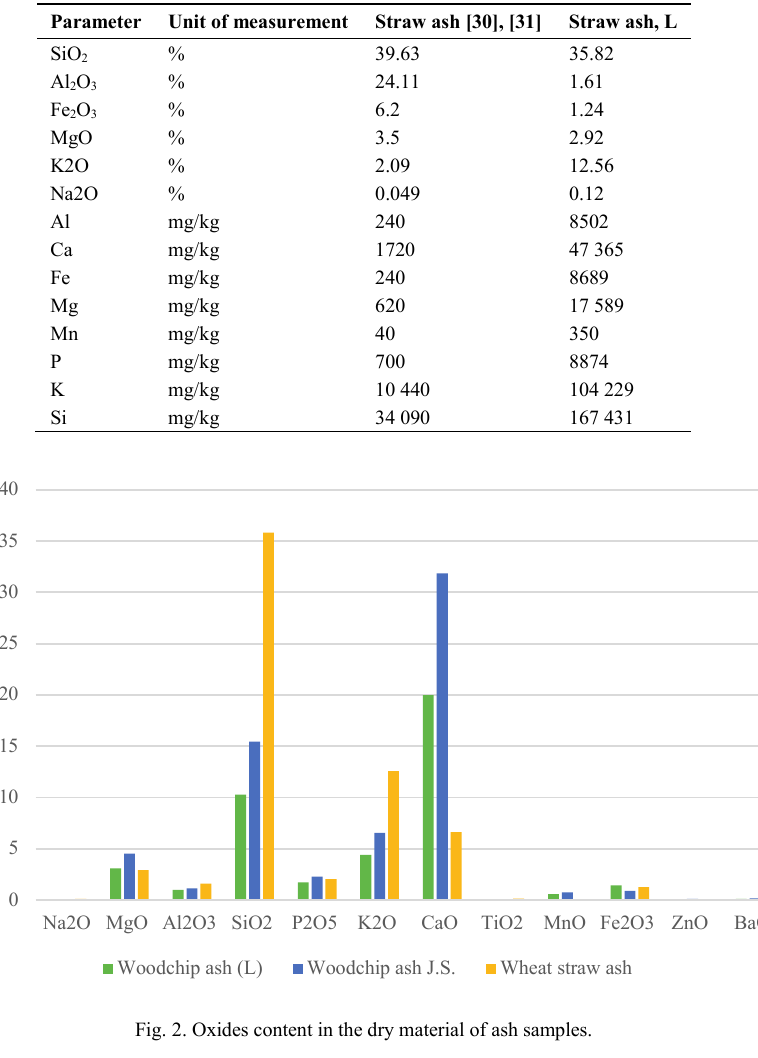
Fig. 2. Oxides content in the dry material of ash